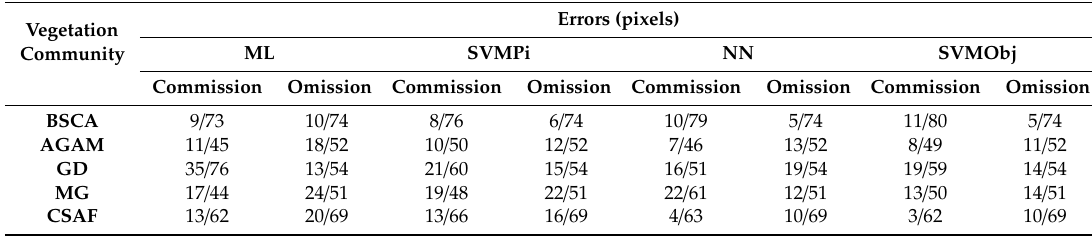
Table 4. Commission and omission errors for each of the vegetation communities. For abbreviations, see main